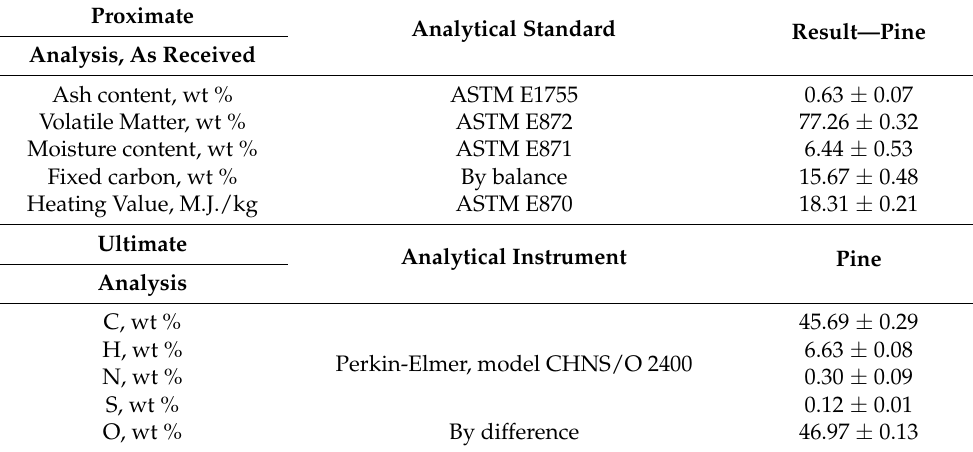
Table 1. Proximate and ultimate analyses of biomass used in this study. Proximate Analytical Standard Result—Pine Analysis, As Received